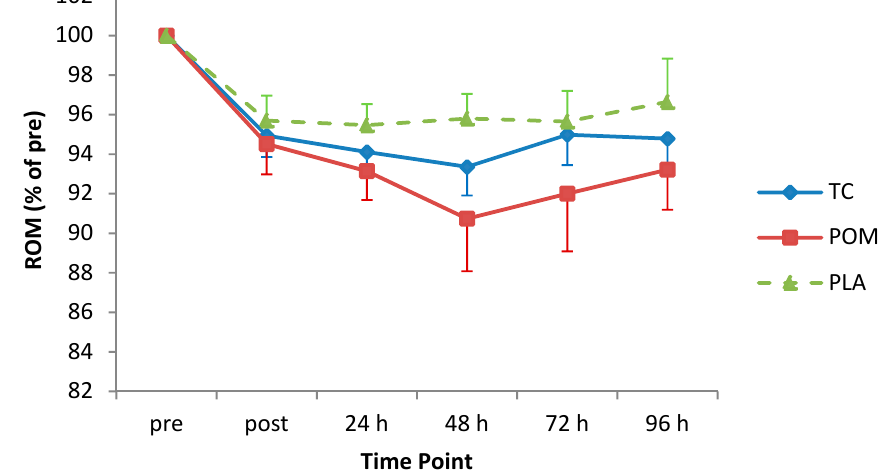
Figure 4. Range of motion (ROM) following eccentric exercise (expressed as a percentage of pre-exercise ROM). Values are displayed as mean (± SEM). Time by treatment, p = 0.71. TC = tart cherry; POM = pomegranate; PLA = placebo, n = 12 for TC and POM; and n = 11 for PLA.